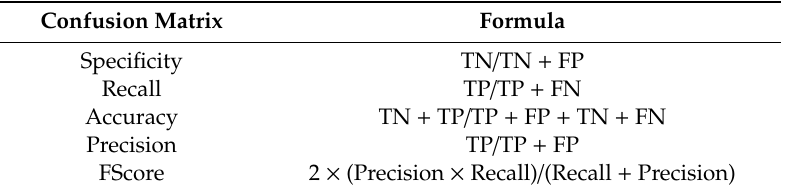
Figure 10. Stability comparison between the integrated SVM classifier and the member classifiers. Table 7. Confusion matrix related metrics.